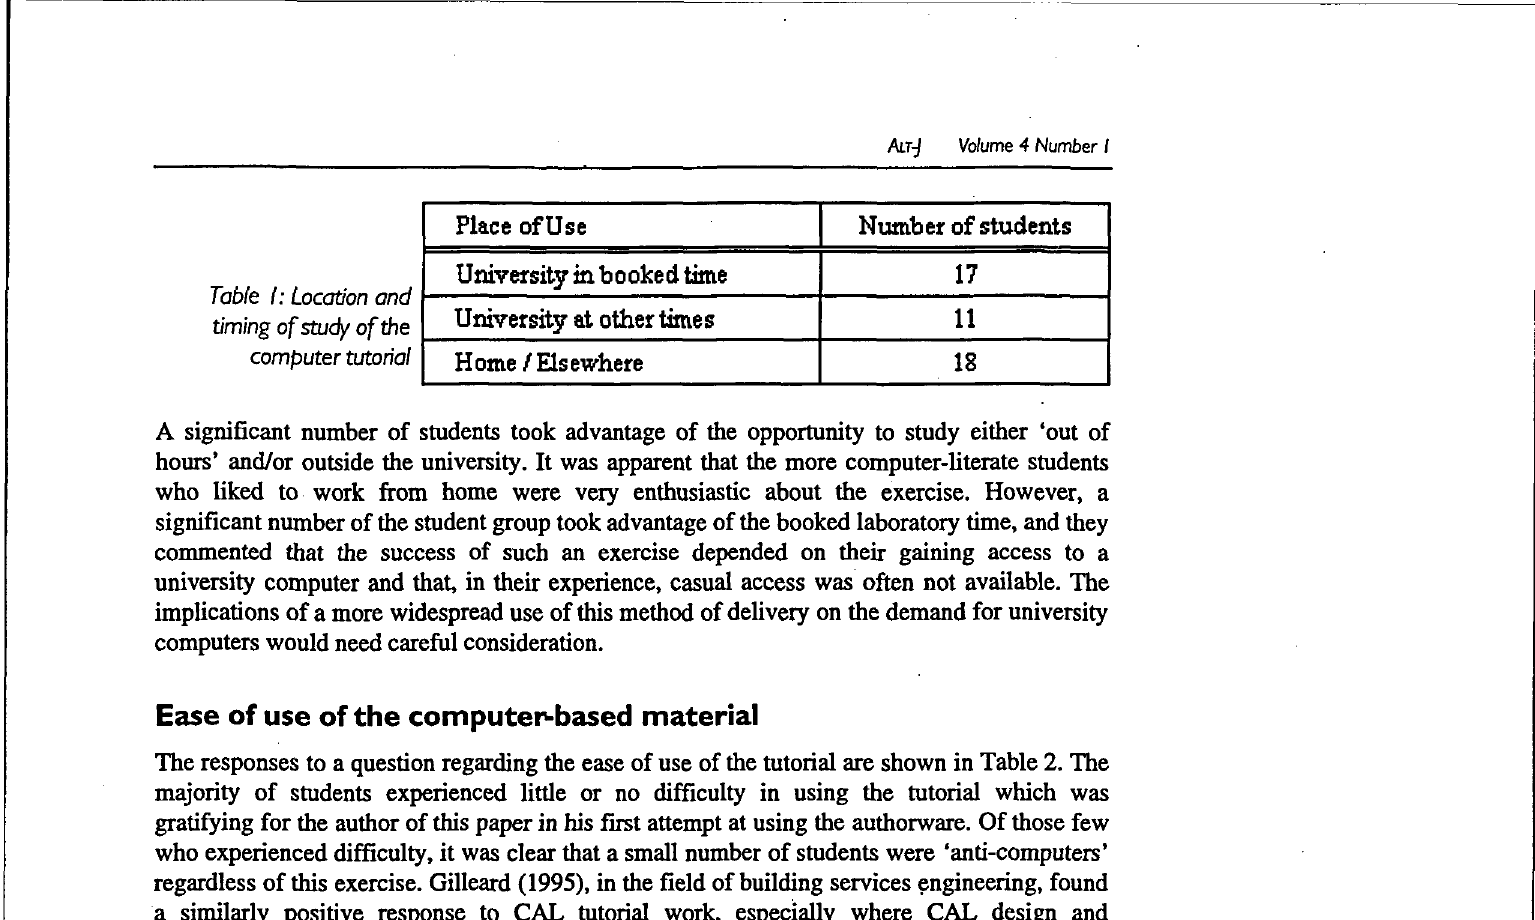
Table 2: Ease of use of